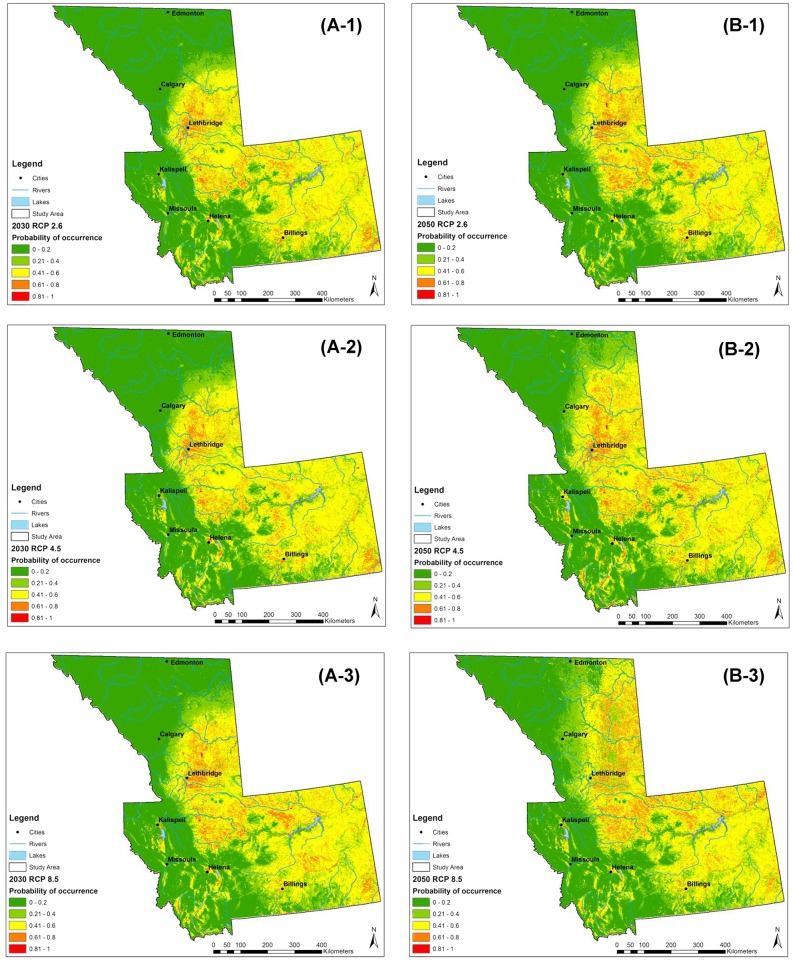
Probability distribution maps of Culicoides sonorensis under different projected climate change scenarios (Representative Concentration Pathways, RCP).A, left panel (2010–2030 scenarios): probability distribution map predicted by MaxEnt for 2010–2030 for each scenario. B, right panel (2030–2050 scenarios): probability distribution map predicted by MaxEnt for 2030–2050 for each RCP scenario. Each RCP is displayed (1) RCP 2.6; (2) RCP 4.5; (3) RCP 8.5.